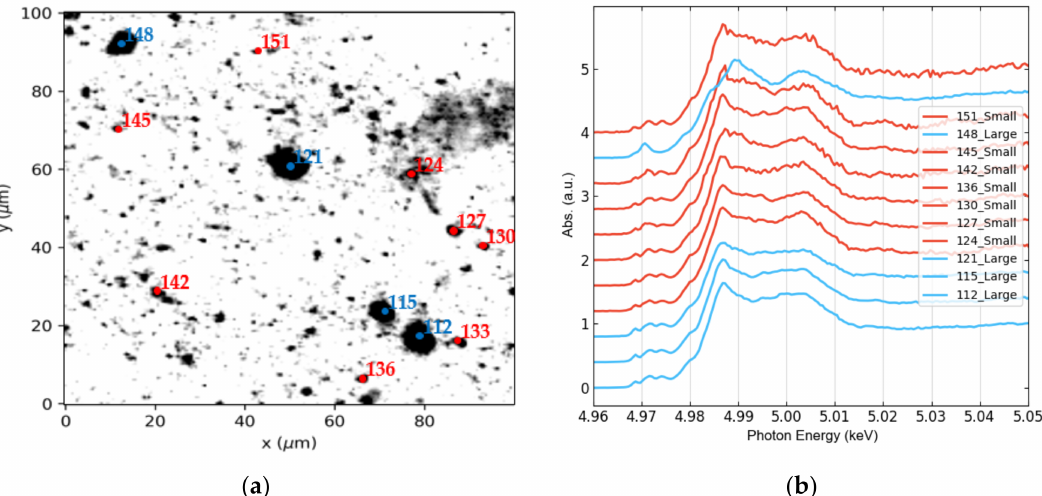
Figure 5. Example of Ti K-edge µ XANES spectra acquired from hotspots of its total level distri- bution map from JZP: ( a ) µ XRF map of Ti including some hotspots selected for µ XANES analysis; ( b ) Corresponding XANES spectra. The color code for Small spots is red and for Large spots is